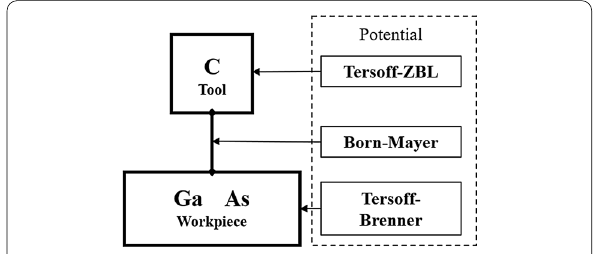
Fig. 4 Cutting force in the nano-cutting